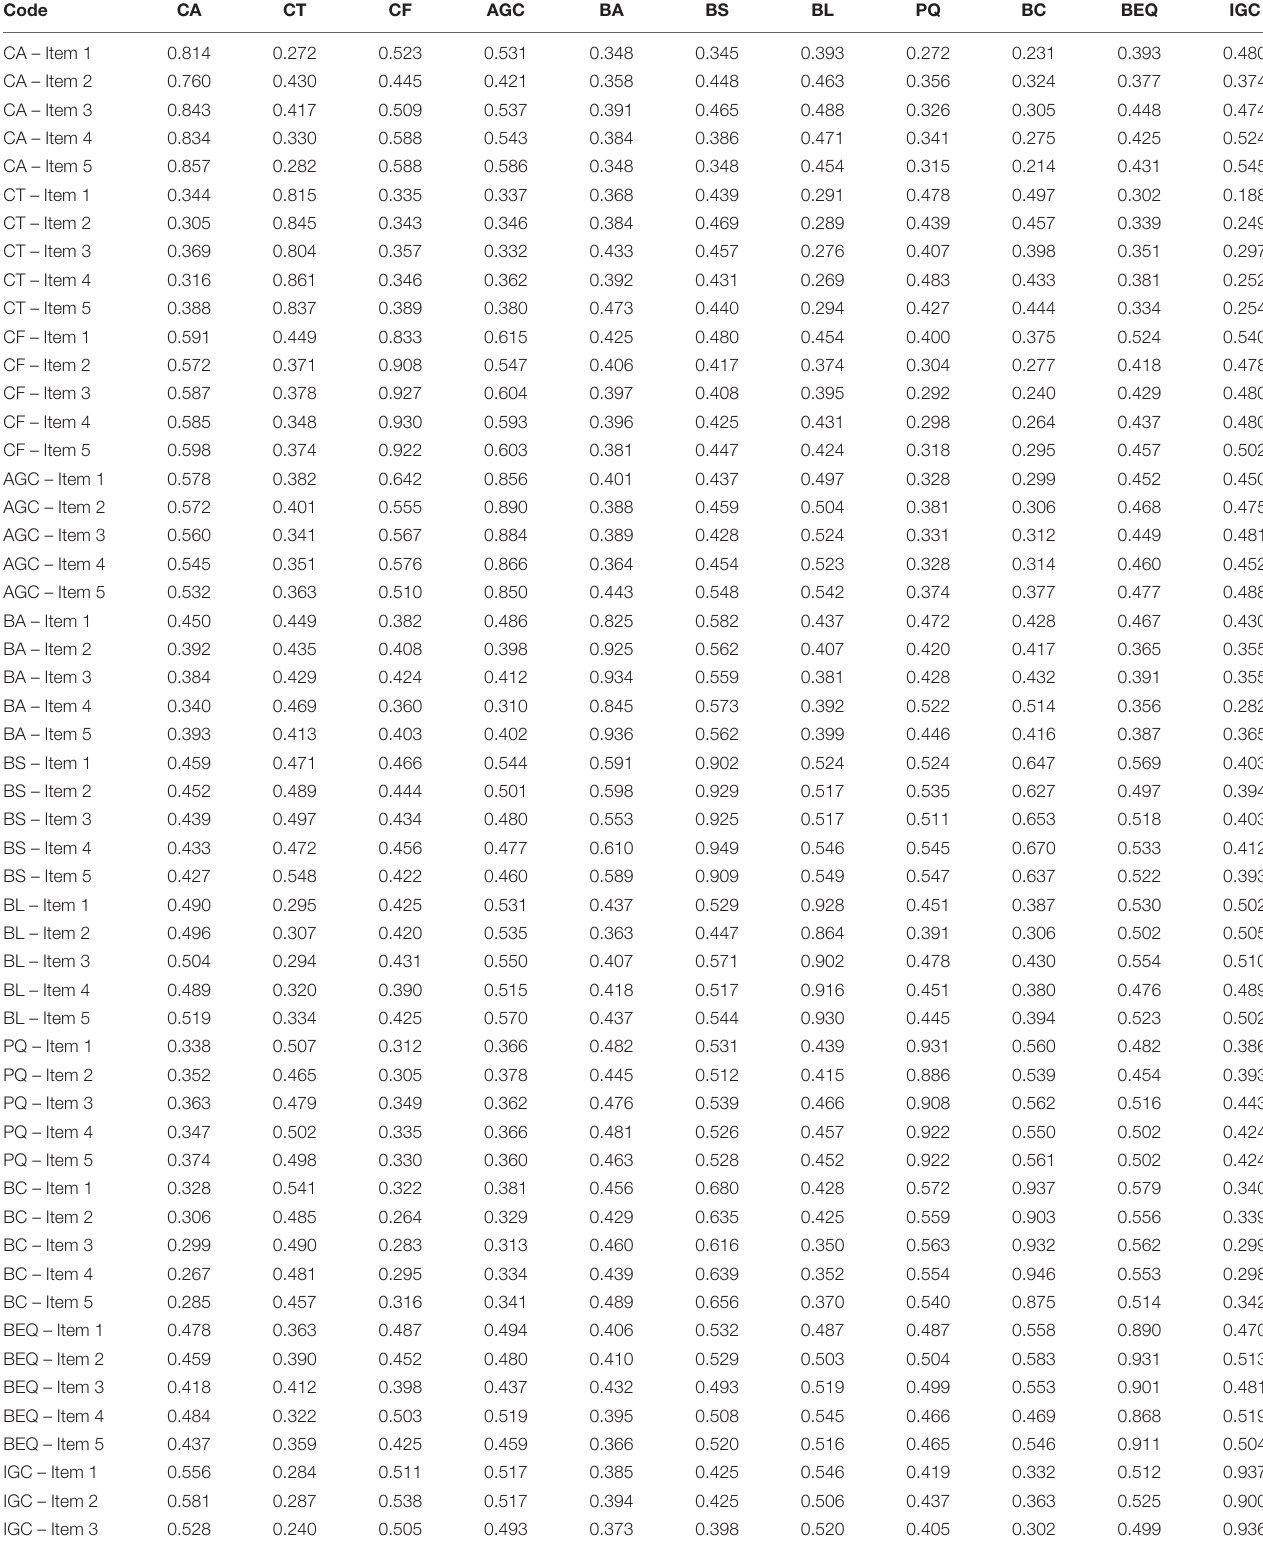
TABLE 5 | Loadings and